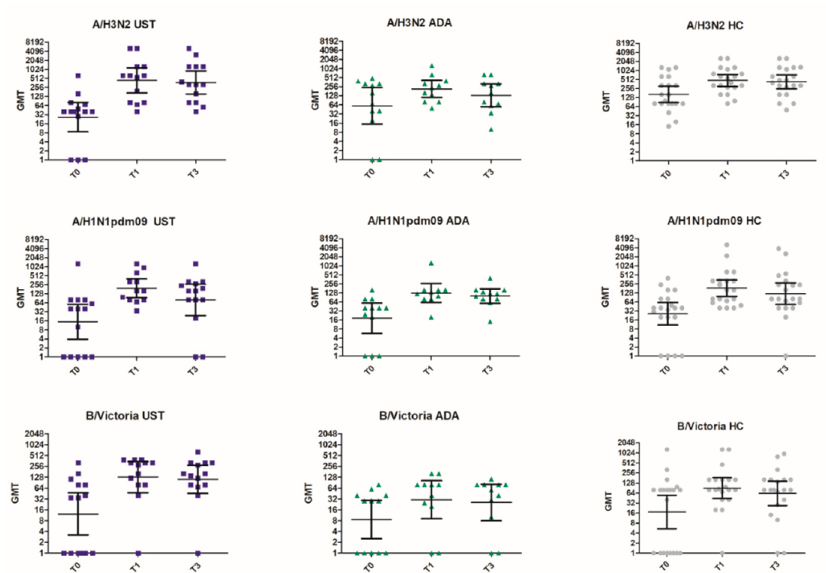
Figure 1. HI titers for each participant to influenza A / H3N2, A / H1N1pdm09, and B / Victoria vaccination per strain and study group. T0 = pre-vaccination, T1 = one-month post-vaccination, T3 = three months post-vaccination, T9 = nine months post-vaccination. UST = ustekinumab group (blue square), ADA = adalimumab group (green triangle), HC = healthy controls (grey circle). Geometric mean titers (GMT) and 95% confidence intervals are shown.